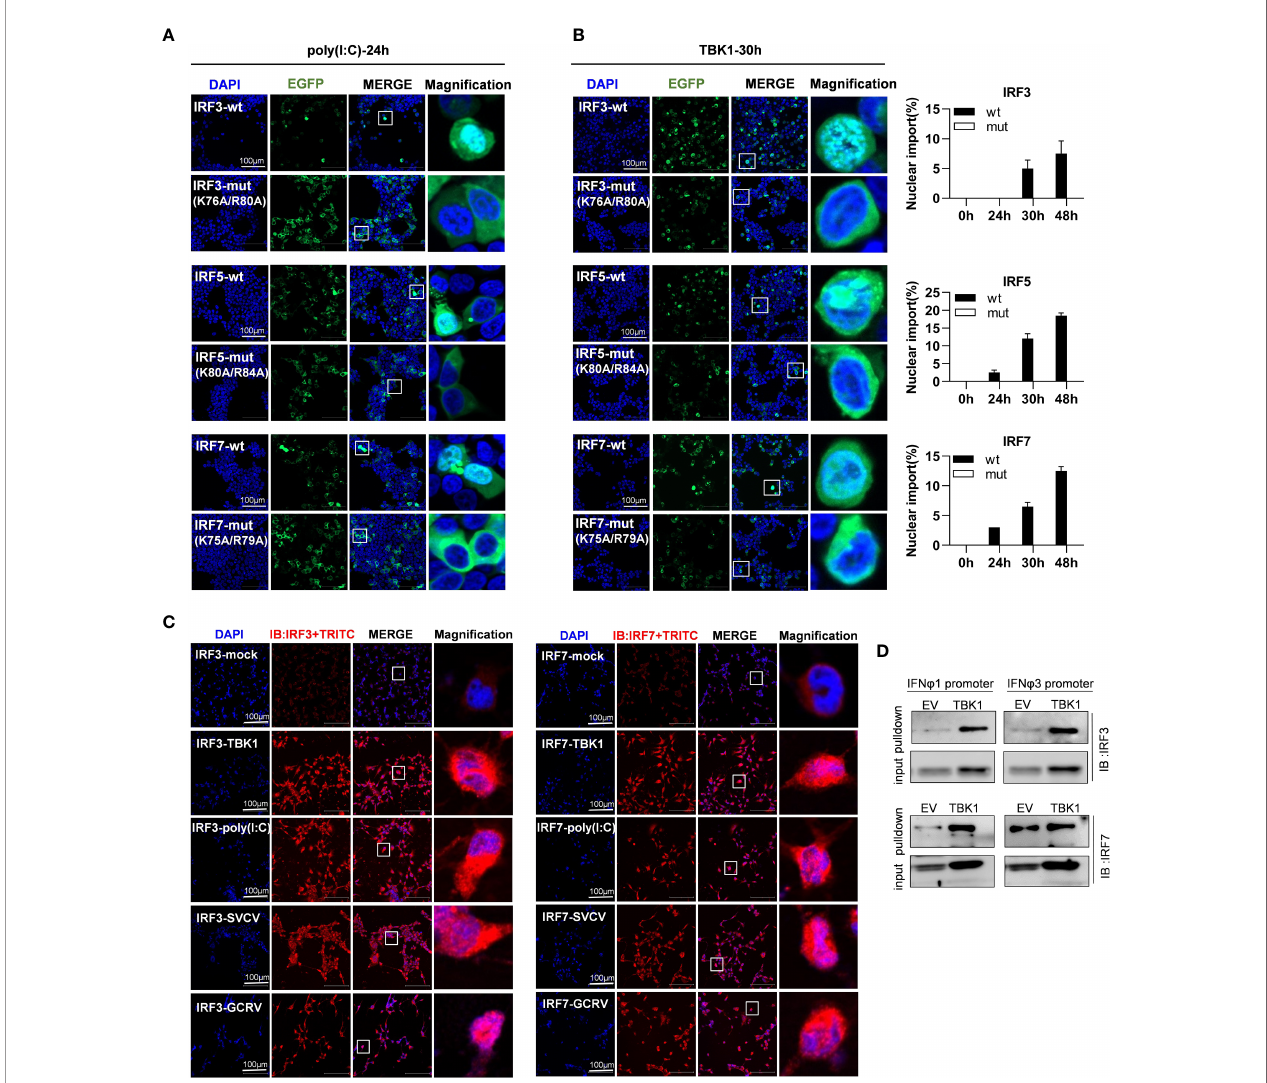
FIGURE 10 | The two basic residues are essential for inducible nuclear import of IRF3/5/7 by transfection of poly(I:C) (A) and TBK1 (B) . (A) Mutation of the two basic residues impaired the inducible nuclear import of IRF3/5/7 by poly(I:C) transfection. HEK293T cells seeded overnight on microscope slide cover-glasses in six-well plates were transiently cotransfected as in Figure 4 for 24h, with the indicated IRF plasmids (2 m g each) and poly(I:C) (100ng/ml). (B) Mutation of the two basic residues impaired the nuclear import of IRF3/5/7 by overexpression of TBK1. HEK293T cells seeded overnight on microscope slide cover-glasses were transiently transfected as in Figure 4 , with the indicated IRF plasmids and TBK1 (2 m g each) for different time points (24, 30, 48h), followed by a time-course confocal microscopy examination. Left panels showed the representative images at 30h post transfection. Right panels: The ratio of the nuclear-translocated cells to total fl uorescent cells was statistically quantitated by cell counting of the whole visual fi eld under confocal microscopy. (C) Immuno fl uorescence microscopy observation of endogenous IRF3 and IRF7 proteins in cells with or without stimulation by IFN stimuli. CO cells seeded overnight on microscope slide cover-glasses were transiently transfected with TBK1 (2 m g) or poly(I:C) (100ng/ml or infected wit SVCV or GCRV(1×10 3 TCID 50 /ml each), or mock treatment as control. 24h later, the cells were fi xed, incubated overnight with polyclonal antibodies of fi sh IRF3 and IRF7, stained with fl uorescent secondary antibody (Alexa Fluor Plus 555 TRITC). Red signal indicated endogenous IRF3 and IRF7 proteins. An enlarged view of the highlighted area in the last column display box. (D) Pull-down analysis of the binding af fi nity of Endogenous IRF3 and IRF7 proteins to fi sh promoter DNA. CO cells seeded overnight in 10cm 2 dishes were transfected with TBK1 or empty vector (5 m g each) for 30h. The biotin-labeled DrIFN j 1 (-586 to +38) or DrIFN j 3 (-1447 to -910) promoter DNA (30 ng each) was incubated with the transfected cell lysates overnight at 4°C, followed by western blotting to detect IRF3 and IRF7 proteins by fi sh antibodies speci fi c to IRF3 and IRF7. Note: the low binding intensities in empty vector-transfected CO cells might be due to the low level of constitutive expressed IRF3 and IRF7, which fi nally resulted in unsaturated protein binding to DNA in the pulldown